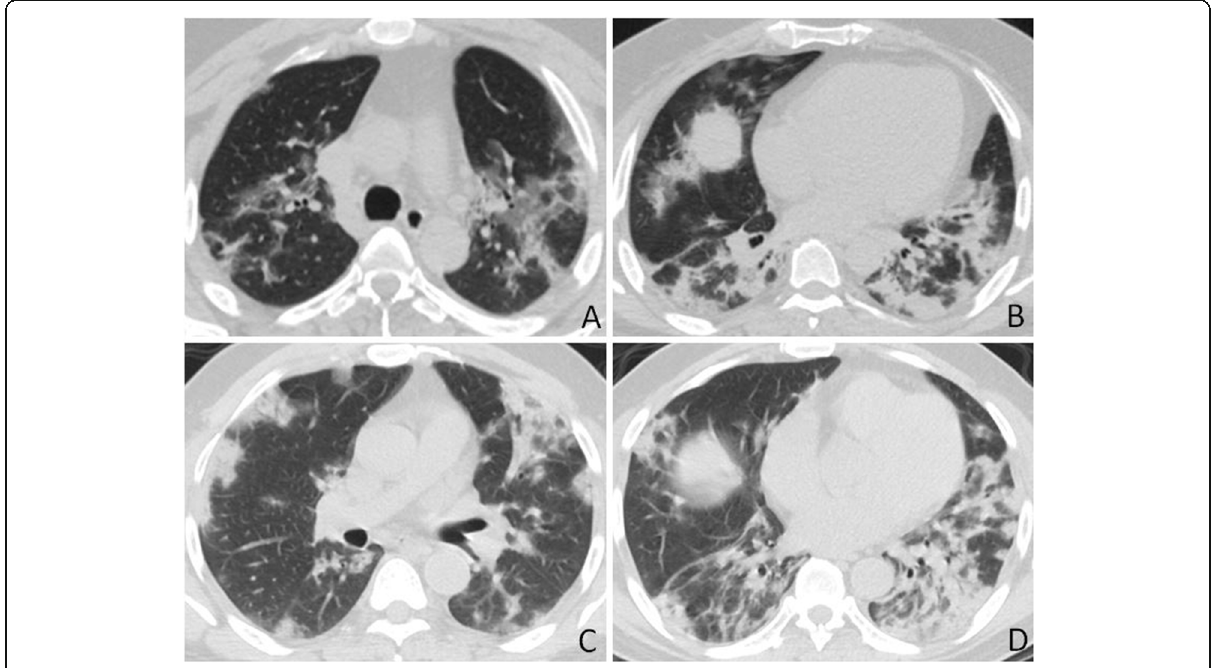
Fig. 2 COVID-19 and influenza A pneumonia misdiagnosed as COVID-19. a and b Axial CT images obtained from a 43-year-old woman with positive PCR test for COVID-19 show peripherally located multifocal areas of poorly defined focal consolidation, small areas of GGO, and bronchial wall thickening. c and d Axial CT images from a 61-year-old man with positive PCR test for influenza A (H1N1) show similar features as a and b with predominant